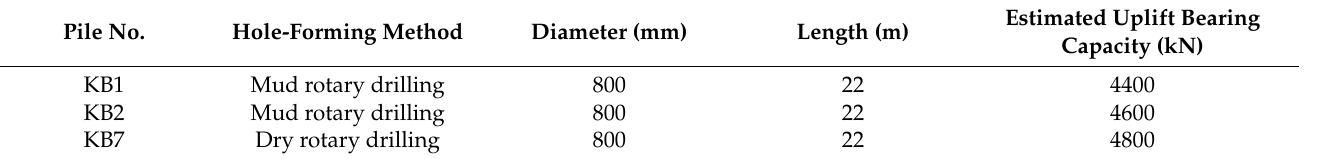
Table 1. Basic parameters of tested